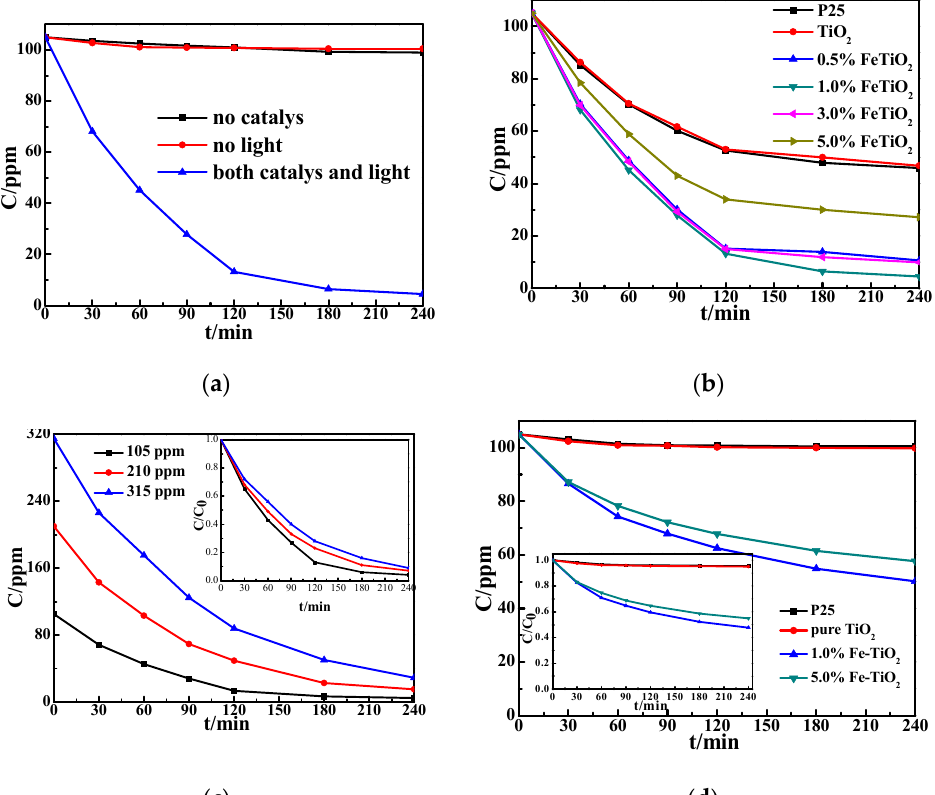
Figure 10. Photodegradation of toluene in the control experiment ( a ), using different catalysts ( b ), under different initial toluene concentrations ( c ) and using visible light ( d ).